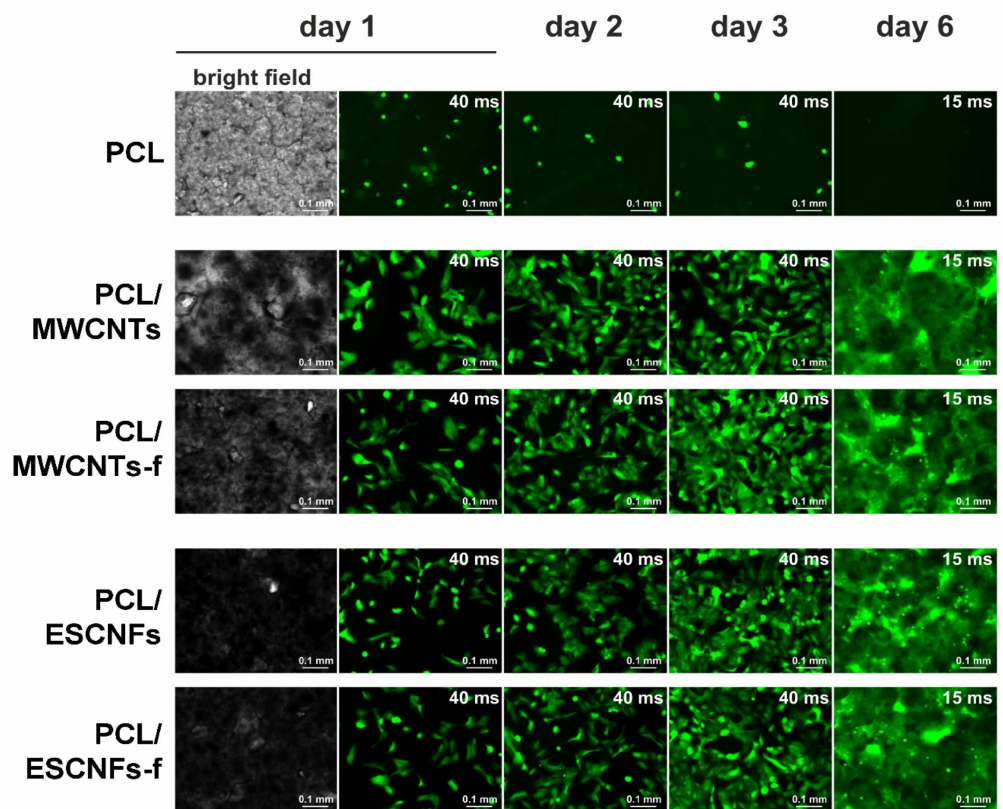
Figure 3. U-2 OS-Green cells expressing green fluorescent protein (GFP) in bright field and cultured for the 1st, 2nd, 3rd (40 ms exposure, gain = 1) and 6th day post-seeding (15 ms exposure, gain = 1), from top: PCL; PCL/MWCNTs, PCL/MWCNTs-f, PCL/ESCNFs and PCL/ESCNFs-f; mag. 10 × (original images were published in [33,34]). The exposure time on the sixth day was reduced due to the appropriate capture of the exposed image. The cell growth experiments were performed at least three times for each material.